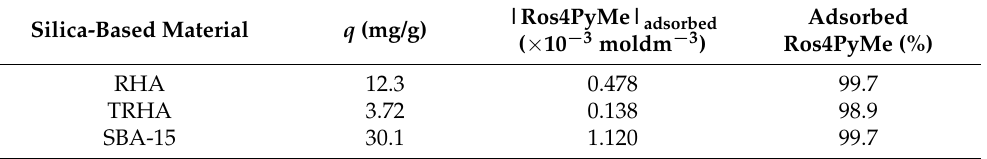
Table 1. Adsorption coefficient, adsorbed concentration of Ros4PyMe and % of adsorbed Ros4PyMe. Silica-Based Material